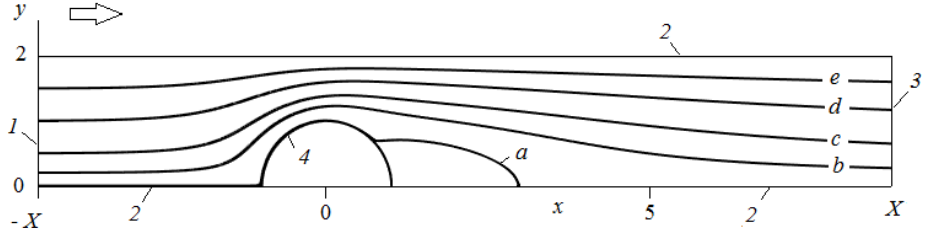
Figure 1. A scheme of the computational cell: flow past a row of parallel fibers, where the Reynolds number (Re) = 20 and a / h = 0.5; the flow direction is shown by the arrow. The streamline ordinates are: 10 − 4 ( a ), 0.2 ( b ), 0.5 ( c ), 1 ( d ), and 1.5 ( e ); 1 —inlet, 2 —symmetry boundaries, 3 —outlet, 4 —fiber surface.